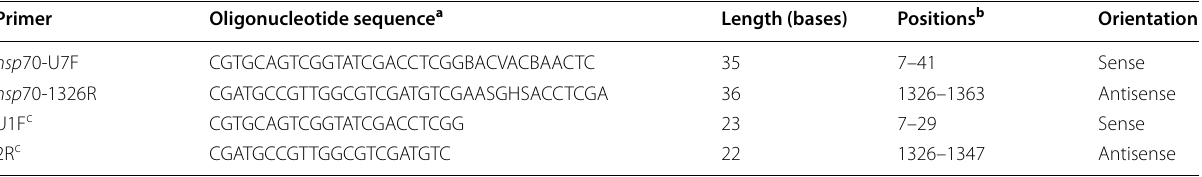
G/C/T; V A/G/C; S C/G; H A/C/T = = = =